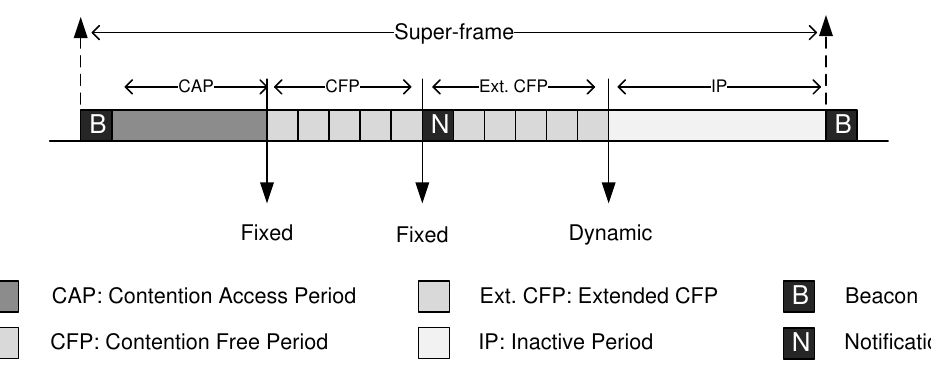
Figure 1. Superframe structure of